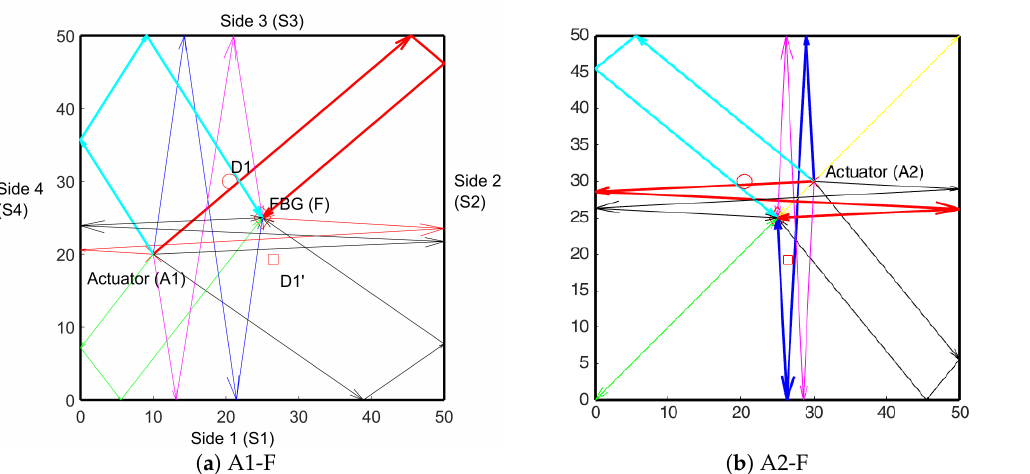
Figure 11. Nomenclature of structure and order 2 reflection paths for the AS pairs ( a ) A1 and ( b ) A2.